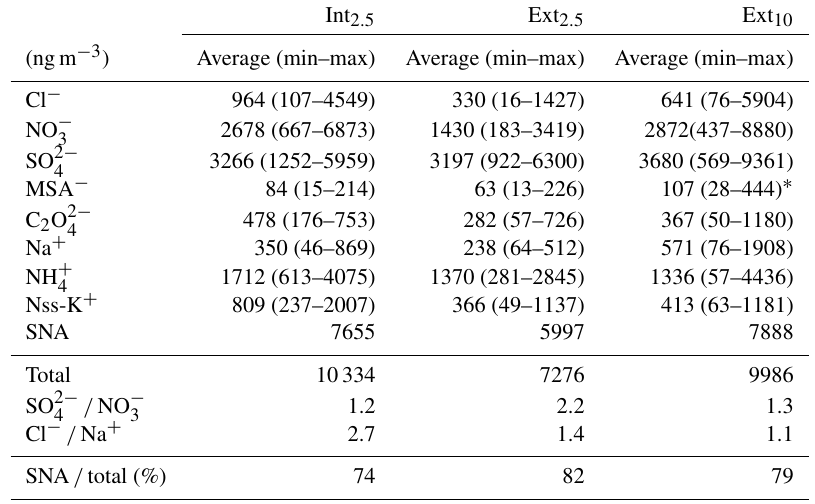
Table 3. Concentrations of WSI in all